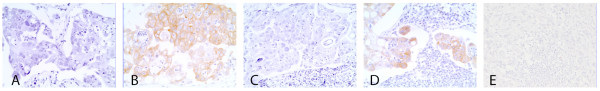
C-erbB-2 overexpressing phenotype: concordant case. PR–, c-erbB-2+ (1A, 1B) in mammary tumor and PR–, c-erbB-2+, p63– (200x) (2C, 2D, 2E) in the respective lymph node metastasis. 400x.